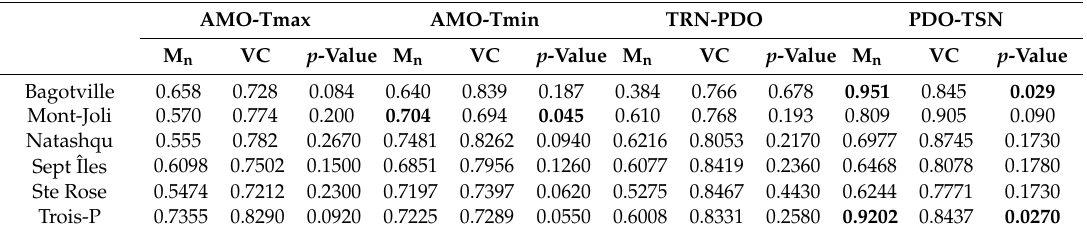
Table 6. Results of the copula method used to analyze changes in dependence between climate variables and winter climate indices (DJFM) (1950–2000) in the eastern